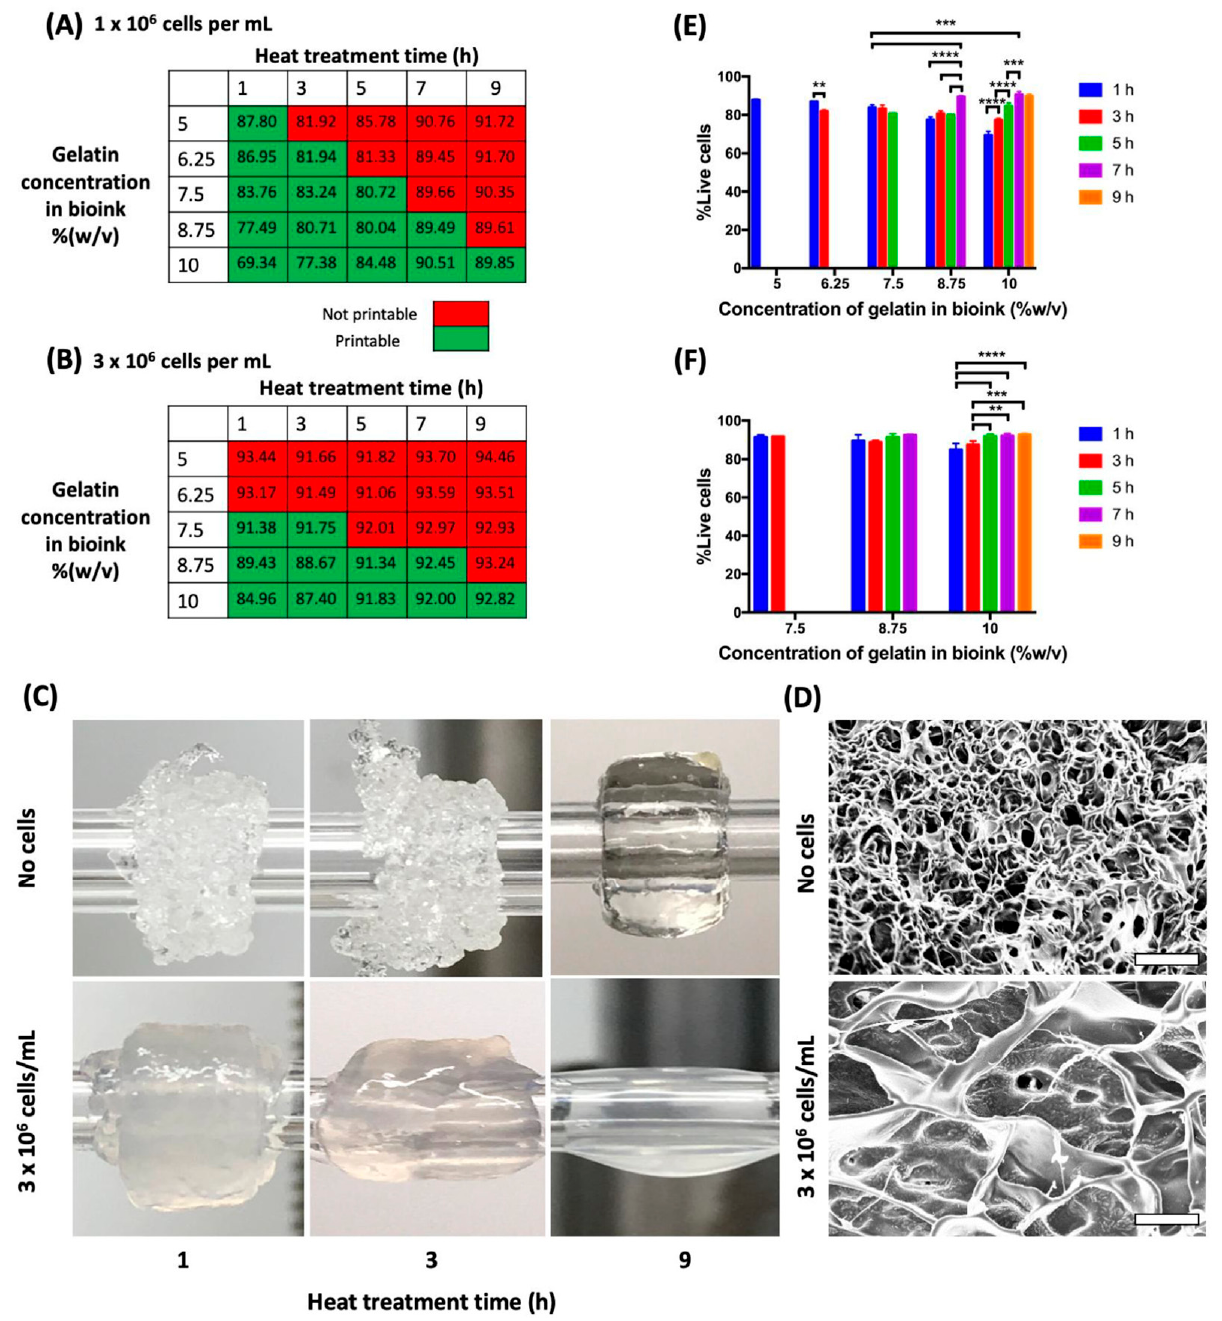
Figure 9. Effect of heat treatment of gelatin on cell viability during 3D rotary printing. ( A ) 1 × 10 6 or ( B ) 3 × 10 6 cells/mL neonatal human dermal fibroblasts (HDF-n) was mixed with the gelatin–fibrinogen bioink for vascular 3D rotary printing. The gelatin was heat treated at 90 C before use in preparing the bioinks. The red regions indicated poor printability of the cell-laden bioinks, while the green regions indicated conditions that held. Average percentage of live cells detected by ethidium homodimer staining are shown in the table. ( C ) The appearance of tubular tissue constructs printed using cell-laden bioinks prepared using 10 mg/mL of fibrinogen and 7.5% ( w / v ) heat-treated gelatin. ( D ) SEM micrographs of the 5% ( w / v ) 1 h heat-treated gelatin + 10 mg/mL fibrinogen. Scale bar: 10 mm. Percentage of live cells in gelatin–fibrinogen bioinks containing ( E ) 1 × 10 6 cells/mL or ( F ) 3 × 10 6 cells/mL. Data are presented as mean ± S.D. *, p < 0.033; **, p < 0.0021; ***, p < 0.0002; and ****, p < 0.0001 [127].